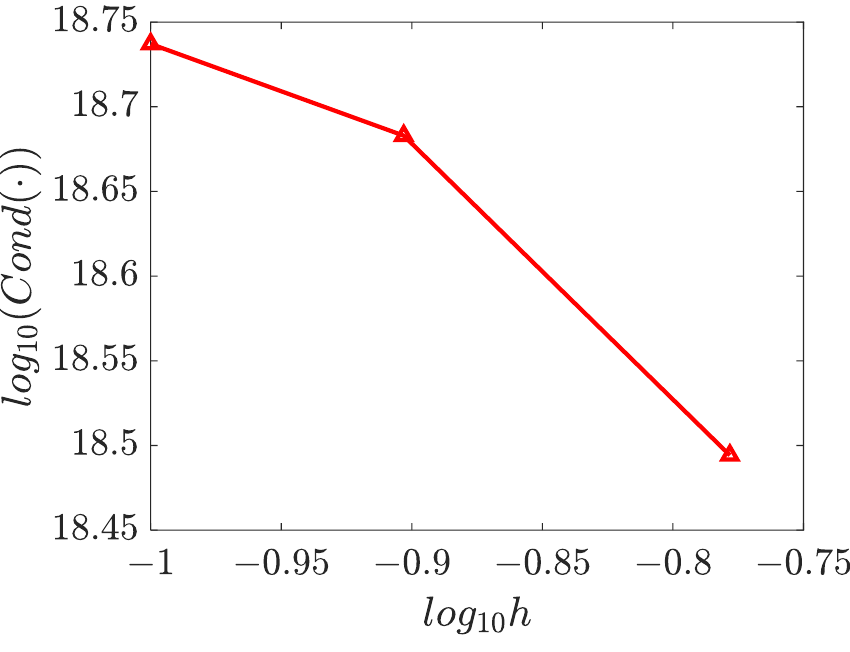
Figure 26. Condition number of stiffness matrix for the 3D parameter identification problem in cubic domain.